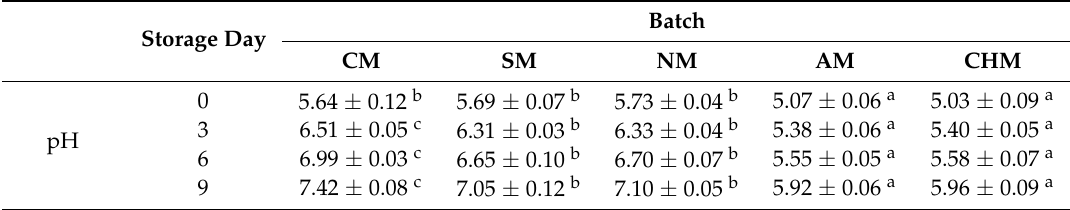
Table 4. pH changes in minced meat added with the preservatives tested during storage. Different letters in the same row indicate significant differences ( p <